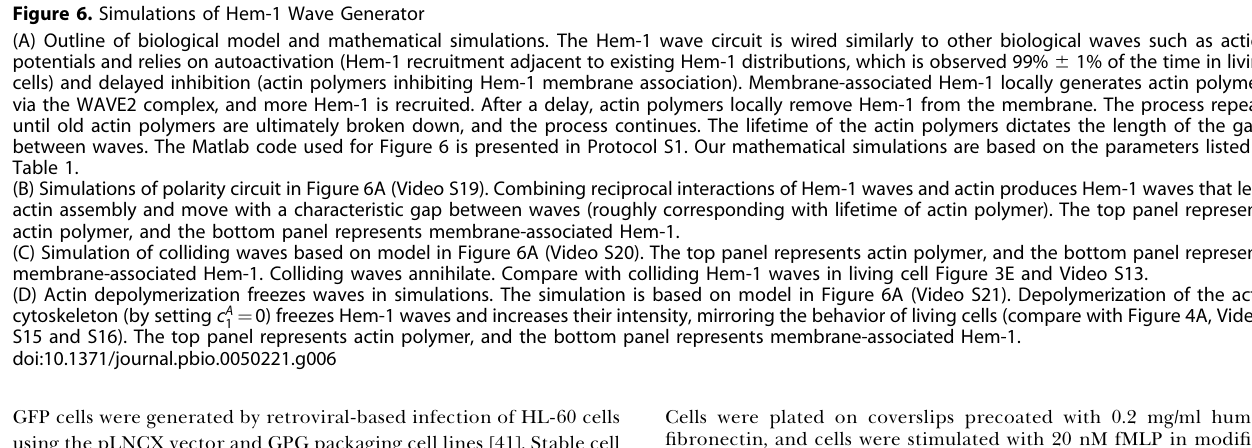
GFP cells were generated by retroviral-based infection of HL-60 cells using the pLNCX vector and GPG packaging cell lines [41]. Stable cell lines were obtained after neomycin selection. Cells were cultured and differentiated as previously described [39].